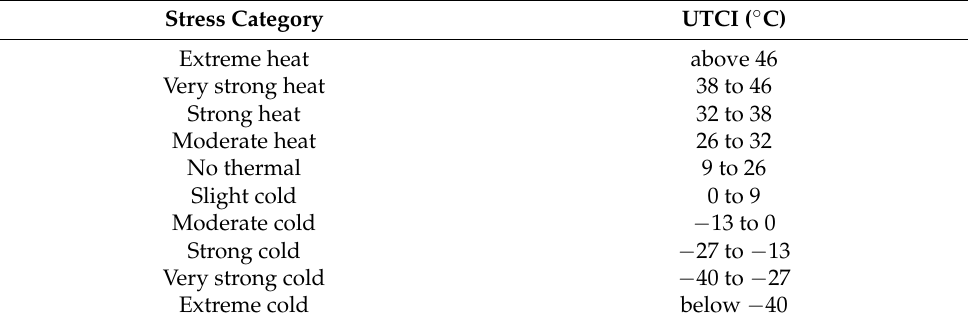
Table 2. Stress category according to UTCI [10].